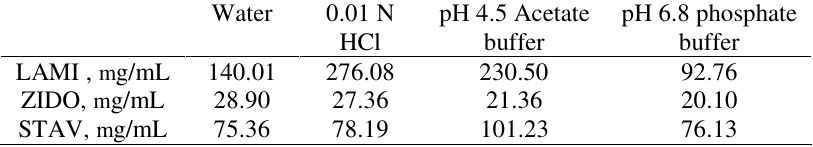
Key: LAMI-Lamivudine, ZIDO-Zidovudine,